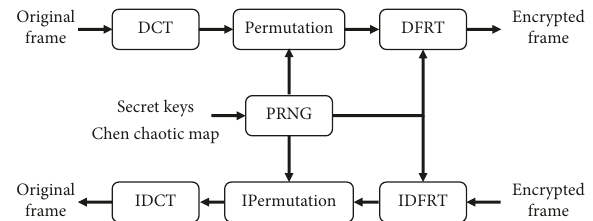
Figure 3: The proposed cryptosystem based on DFRT and